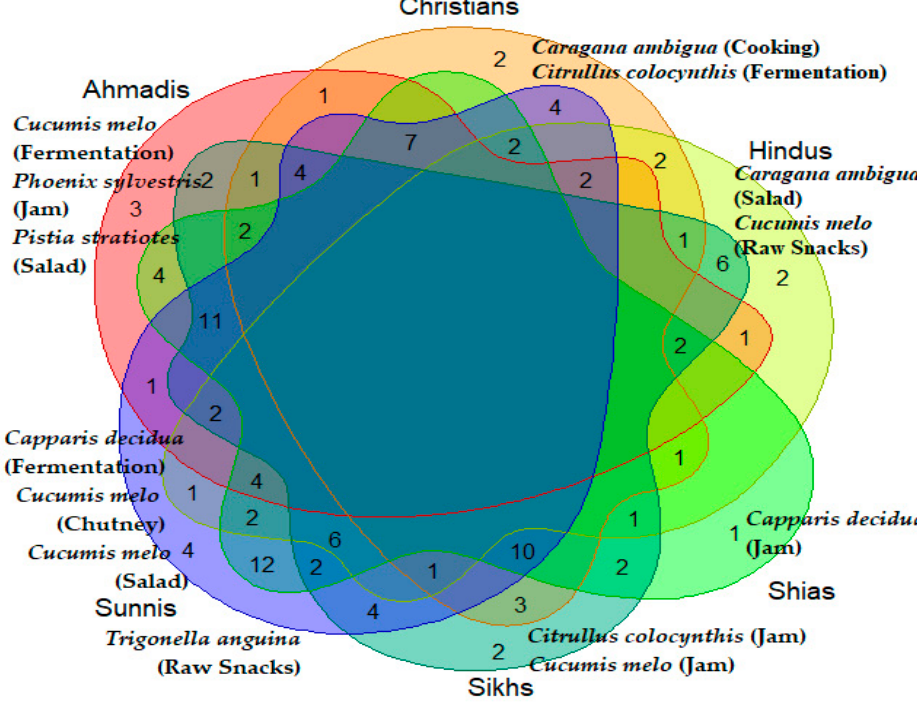
Figure 9. Venn diagram showing the number of overlaps of the recorded wild food plant uses among the studied religious groups; the diagram shows also the food uses uniquely recorded within each group.